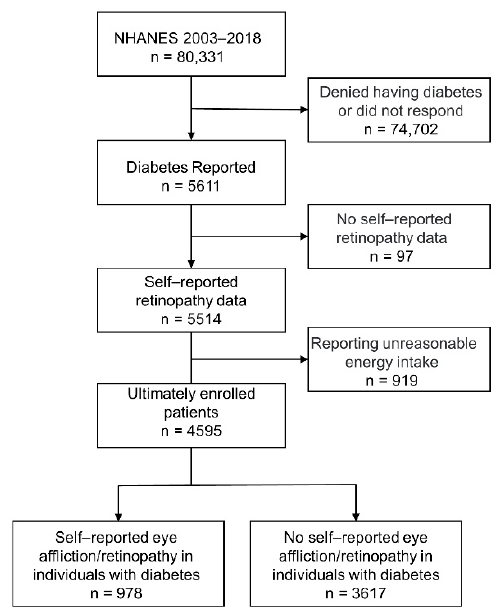
Figure 1. Study participant selection flowchart.